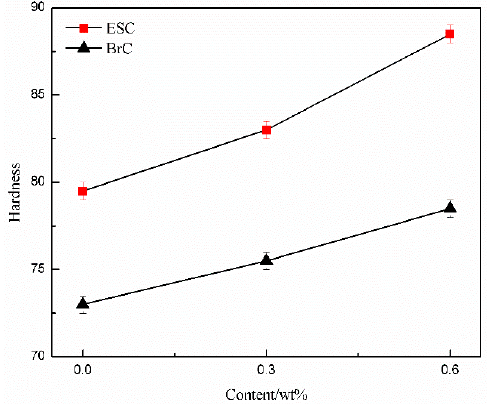
Figure 3. Surface hardness of ESC and BrC with different MWCNT content.